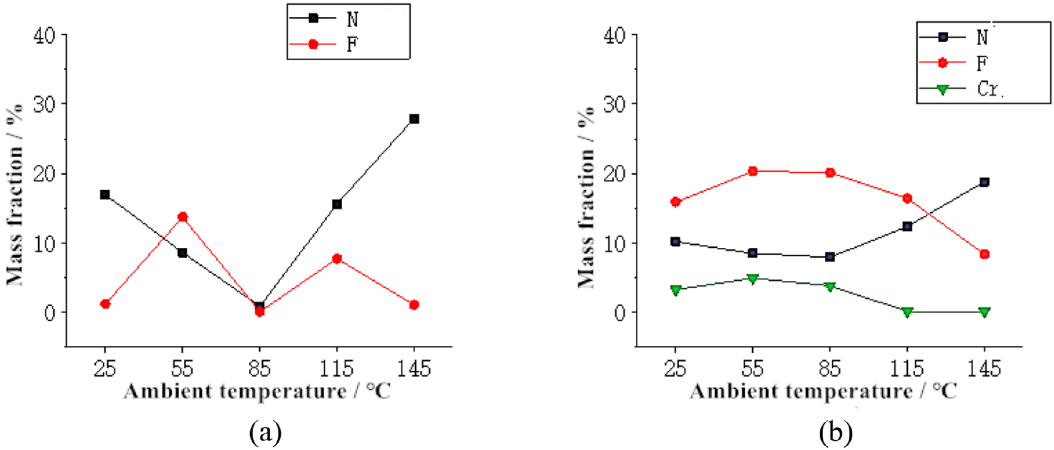
Fig. 11. Characteristic element content of the transfer fi lm on the friction surface. (a) Inner ring (b)